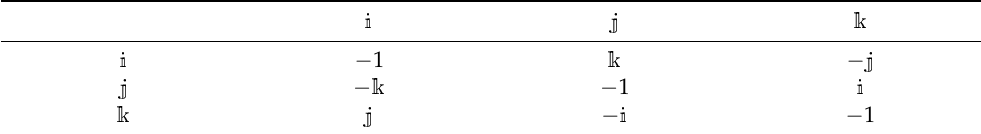
Table 1. The main